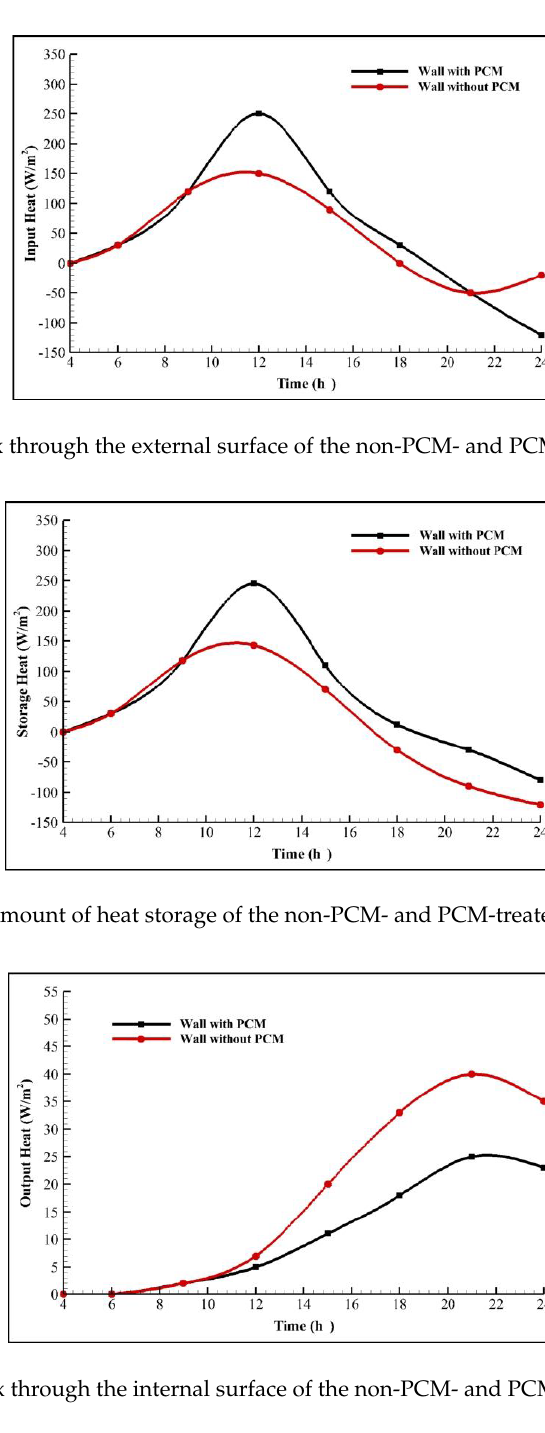
Figure 13. Heat flux through the external surface of the non ‐ PCM ‐ and PCM ‐ treated west walls.